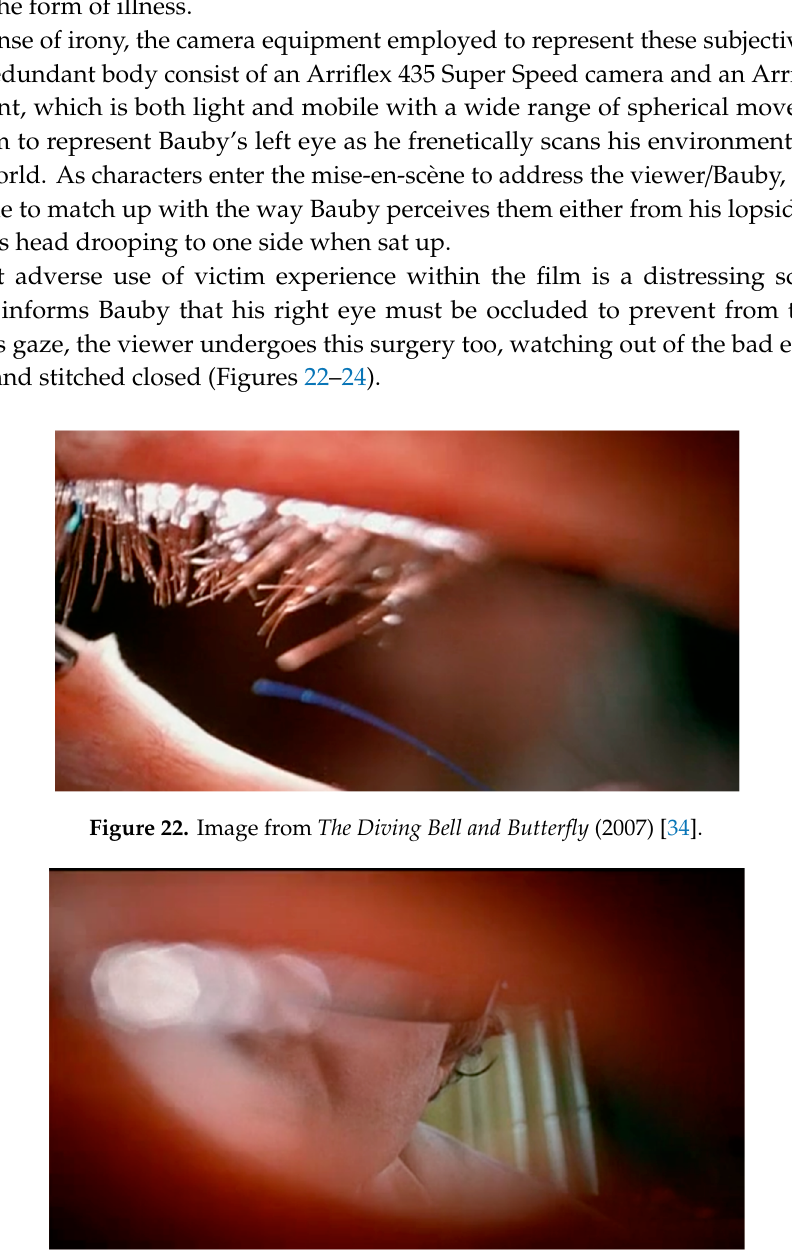
Figure 23. Image from The Diving Bell and Butterfly (2007) [34].